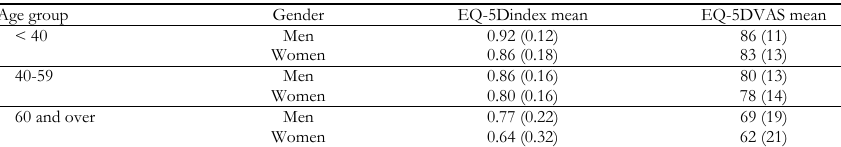
EQ-5D index mean and VAS mean for gender and age